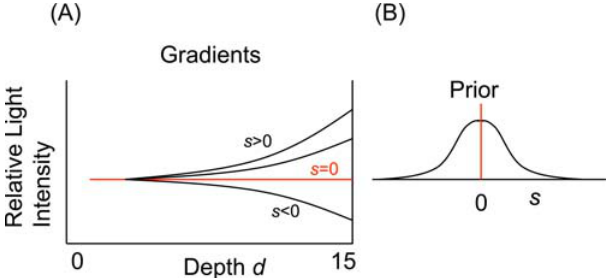
Figure 10. Prior for lightness perception. (A) Possible gradients of illumination indexed by a parameter s . (B) Prior distribution on the light field.